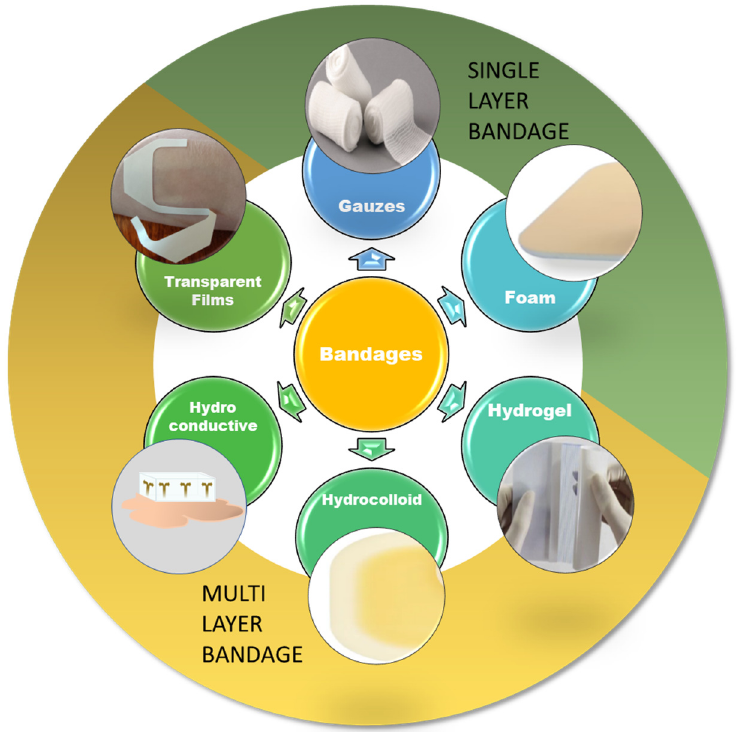
Figure 4. The traditional bandages and their grouping into single- and multiple-layer structures. Hydrogel reprinted with permission from Heliyon, Copyright 2020, Elsevier [20].